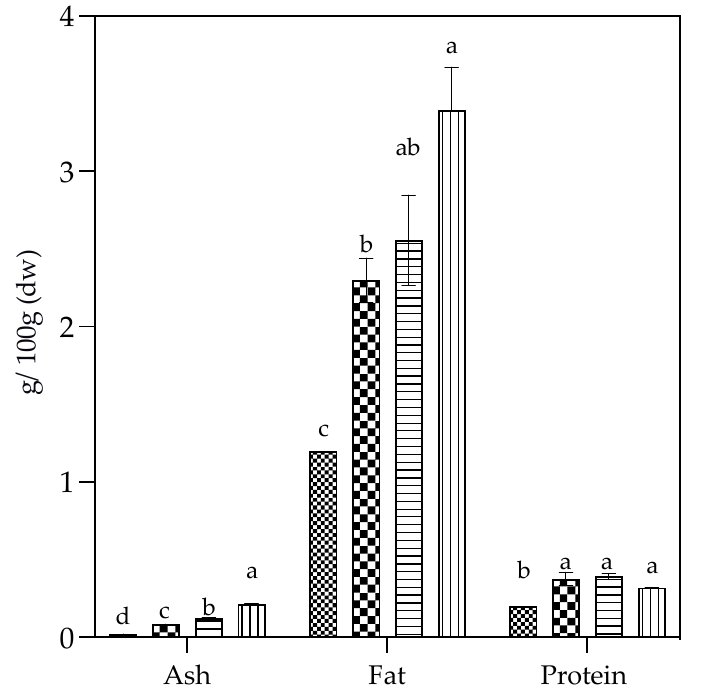
Figure 2. Ash, fat, and protein content of maize porridges. The results are expressed mean ± SD